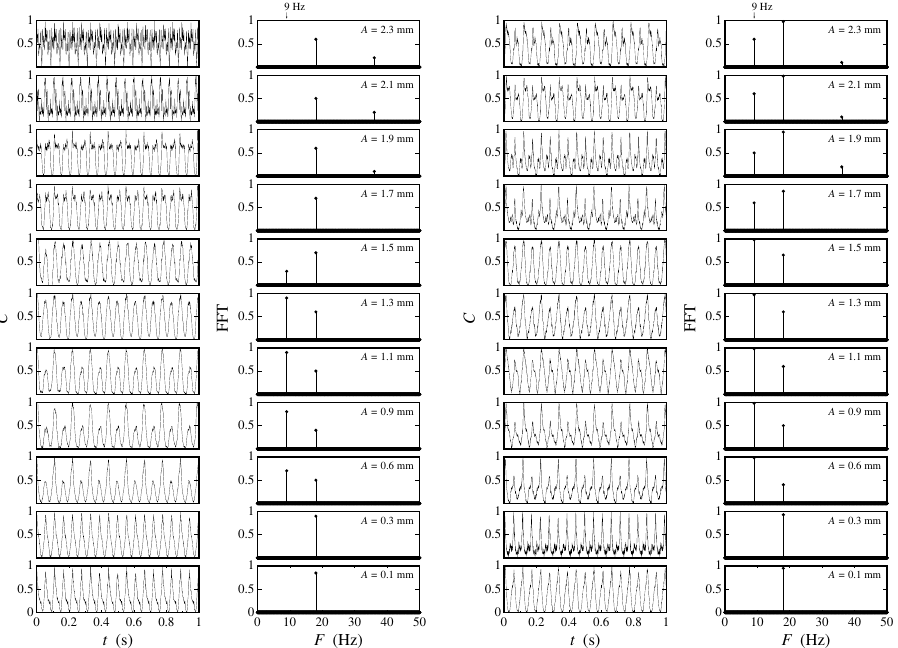
Figure 8. Pearson correlation coefficients as a function of time and corresponding frequency spectrum for F = 18 Hz and varying amplitudes from 0.1 mm to 2.3 mm. The two columns of plots on the left are for the small ( l = 2.5 cm) cells, while the two columns of plots on the right are for the larger ( l = 5 cm)